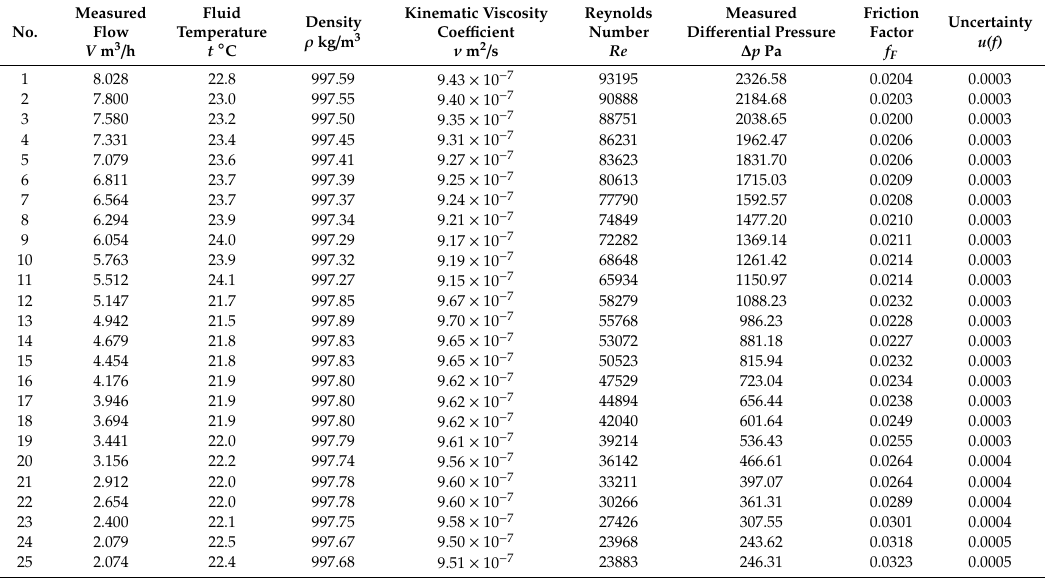
Friction factor values obtained experimentally and calculated values of the measurement